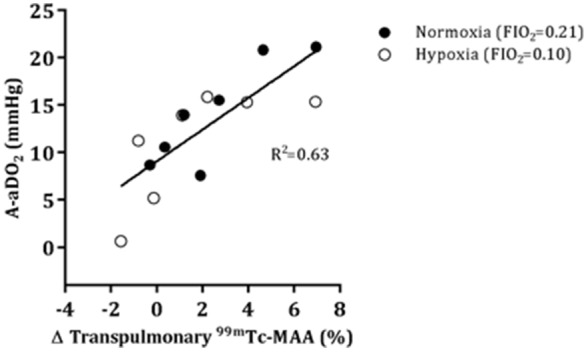
Relationship between transpulmonary 99mTc-MAA passage and the alveolar-arterial oxygen difference (A-aDO2) in normoxic and hypoxic exercise.Line represents the result of a general linear model analysis in which the transpulmonary 99mTc-MAA passage was linearly correlated with the A-aDO2 (R2 = 0.63), but this relationship was not dependent on the FIO2 (p>0.05).